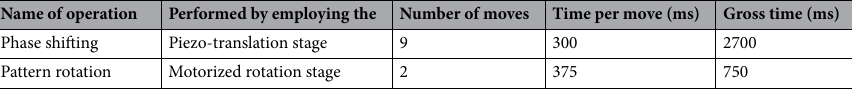
Table 1. Image acquisition speed of tSIM